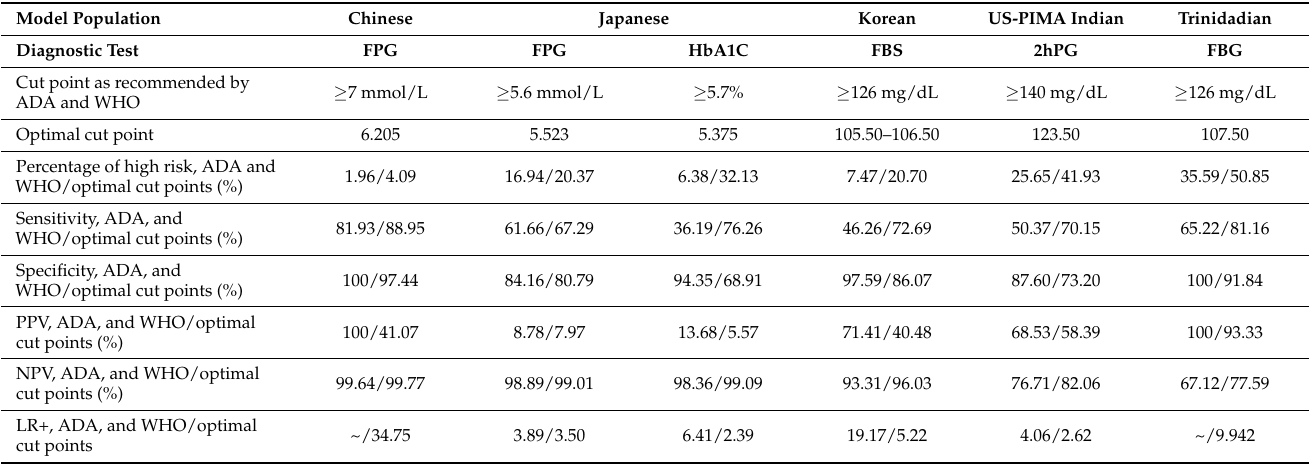
Table 8. Performance of diabetes score in the Chinese, Japanese, Korean, US-PIMA Indian, and Trinidadian adult